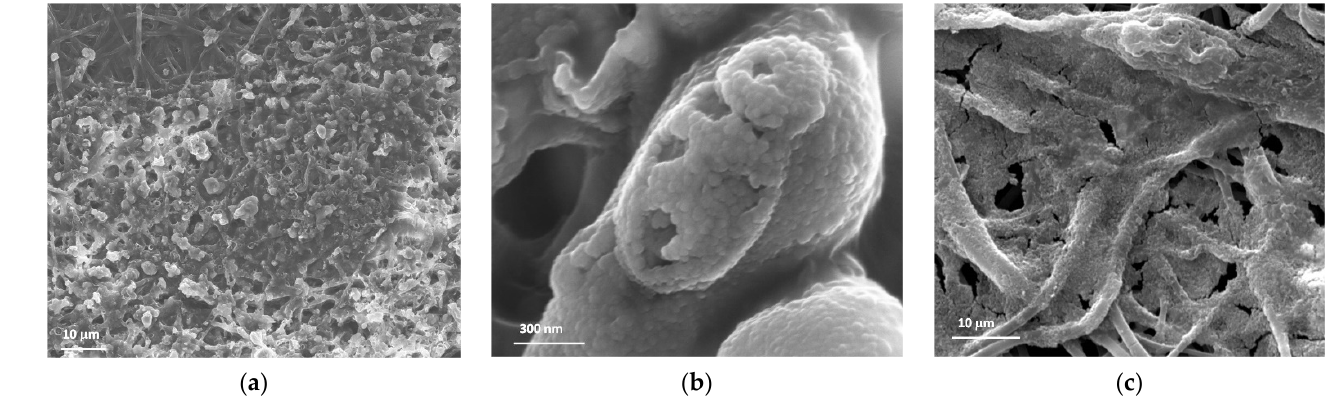
Figure 5. Ca/P, Ca/Si, P/Si ratios at different time of SBF soaking (0, 3, 14 and 28 days) evaluated by XPS analysis.